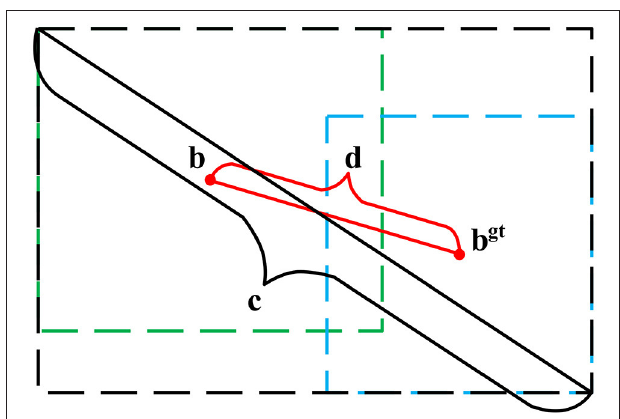
FIGURE 5 | Schematic diagram of DIoU.